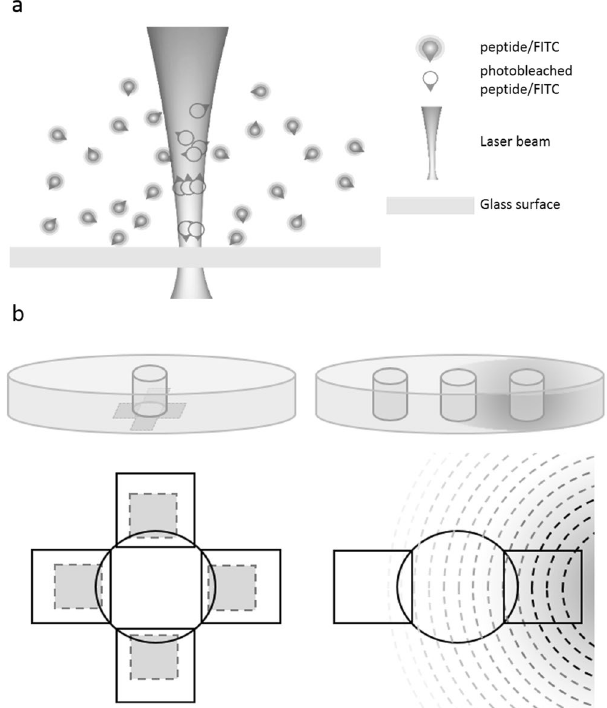
Figure 1. Schematic illustration of haptotaxis and classic under-agarose chemotaxis assay. ( a ) Optical patterning. The glass surface is incubated with FITC-tagged peptides. A focused laser beam photobleaches the molecules and binds it to the surface. ( b ) Side and top views of agarose-layered dishes (35 mm ø) with a central well (2 mm ø) to seed neutrophils. Top view of the central well shows the typical designs with multiple field-of- views alternatively imaged using a motorised stage. ( Left panel ) Substrate-bound gradients (shaded rectangles) are patterned at the bottom of the dish, on the glass surface, overlapping with the central well. ( Right panel ) A side well is filled with chemoattractant solution and the opposing side well with appropriate